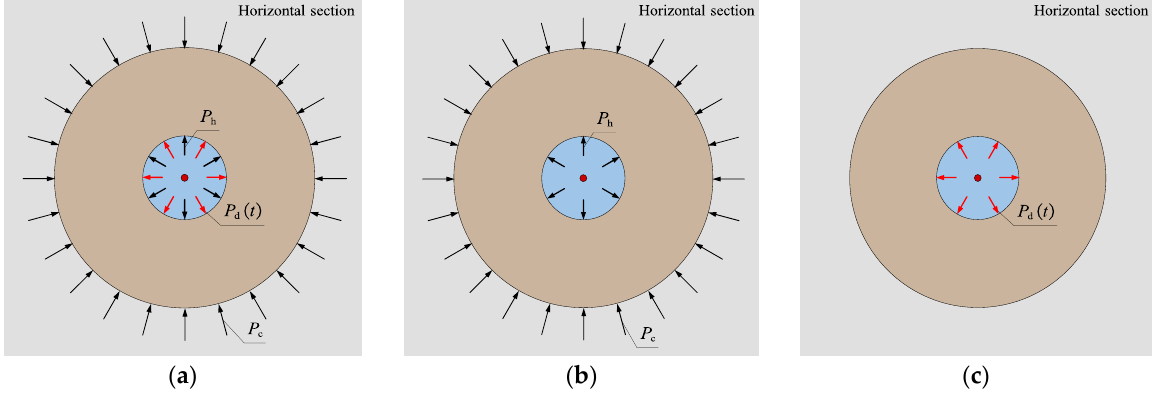
Figure 3. Schematic diagram in the plane strain condition. ( a ) The model under the combination of dynamic and static loads; ( b ) under static loads; ( c ) under discharge loads.